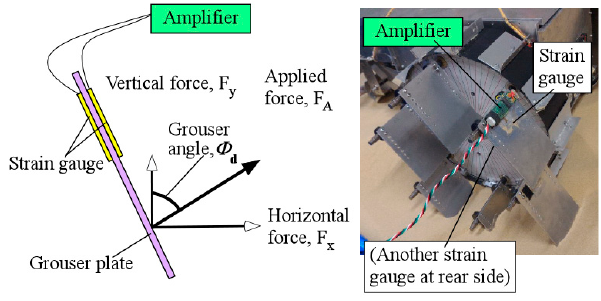
Figure 6. Force measurement using strain gauges attached to grouser.